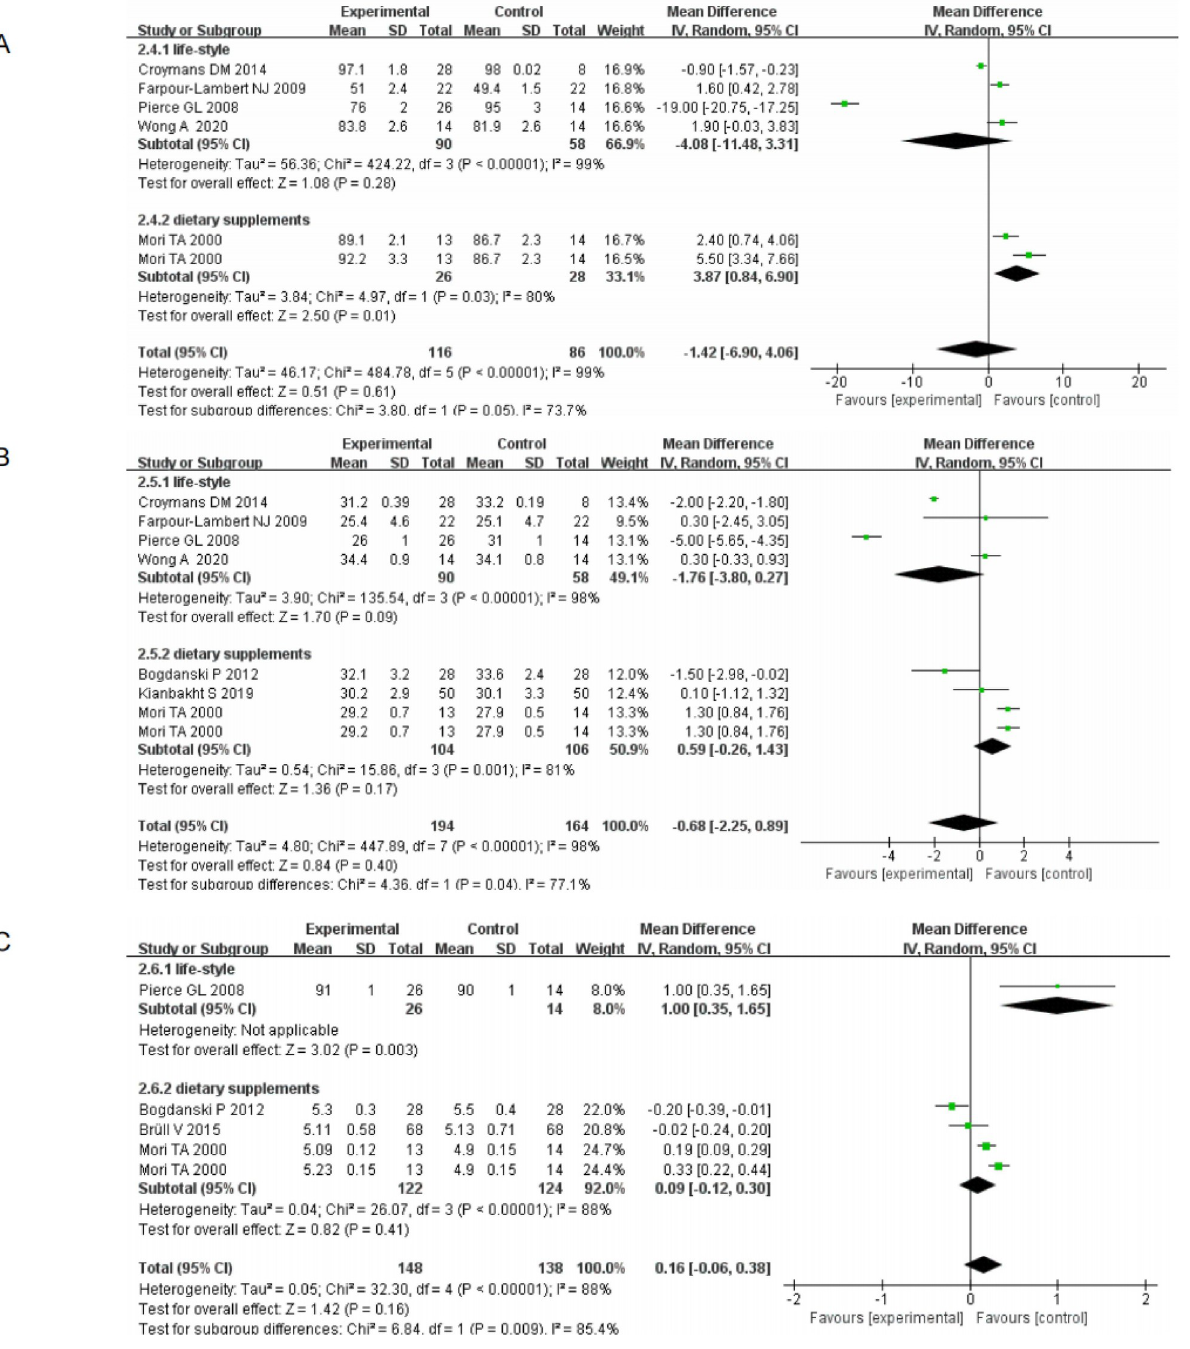
Fig 4. Forest plot of primary outcome indicators(II) (A) Boby weight Forest plot of primary outcome indicators (B) BMI Forest plot of primary outcome indicators (C) Glucose Forest plot of primary outcome indicators.